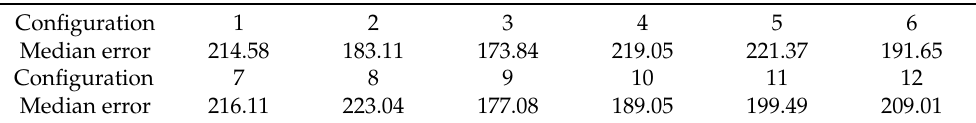
Table 6. RMSE over test input data median and average prediction error of 50 models for each configuration described in Table 5.